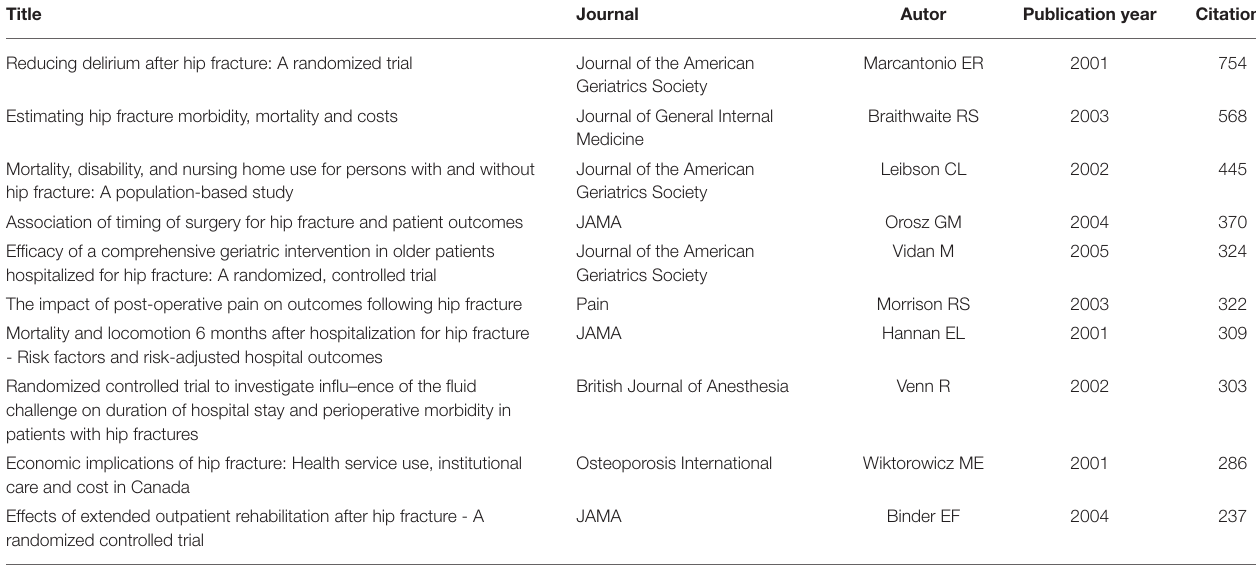
TABLE 2 | The top 10 most-cited papers in the study on rehabilitation of hip fracture in the